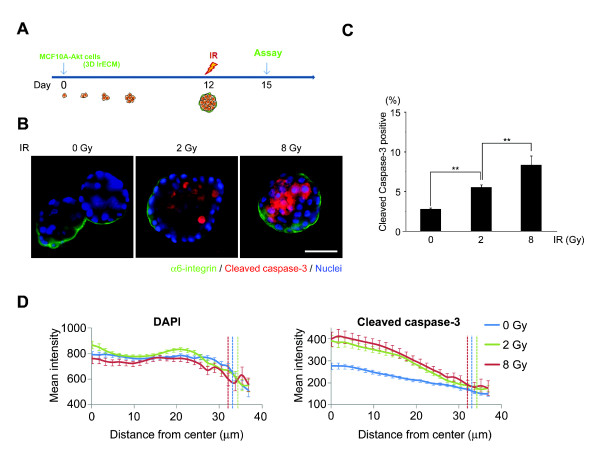
IR induces apoptosis in an active Akt-overexpressing model of human DCIS in three-dimensional lrECM. (A) Experimental schema. (B) IR-induced apoptosis was specifically observed in the luminal compartment of MCF10A-Akt structures. (Green = α6-integrin; red = cleaved caspase-3; blue = nuclei) Bar = 50 μm. (C) High content image analysis confirmed an increasing percentage of cells positive for cleaved caspase-3 with increasing IR doses. (n = 200 acini, **, P < 1E-7) (D) Concentric measurements of mean intensity of cleaved caspase-3 showed significantly higher signal in the lumina of irradiated acini, compared to unirradiated controls. Dashed lines indicated edge of the acini. DCIS, ductal carcinoma in situ; IR, ionizing radiation; lrECM, laminin-rich extracellular matrix.